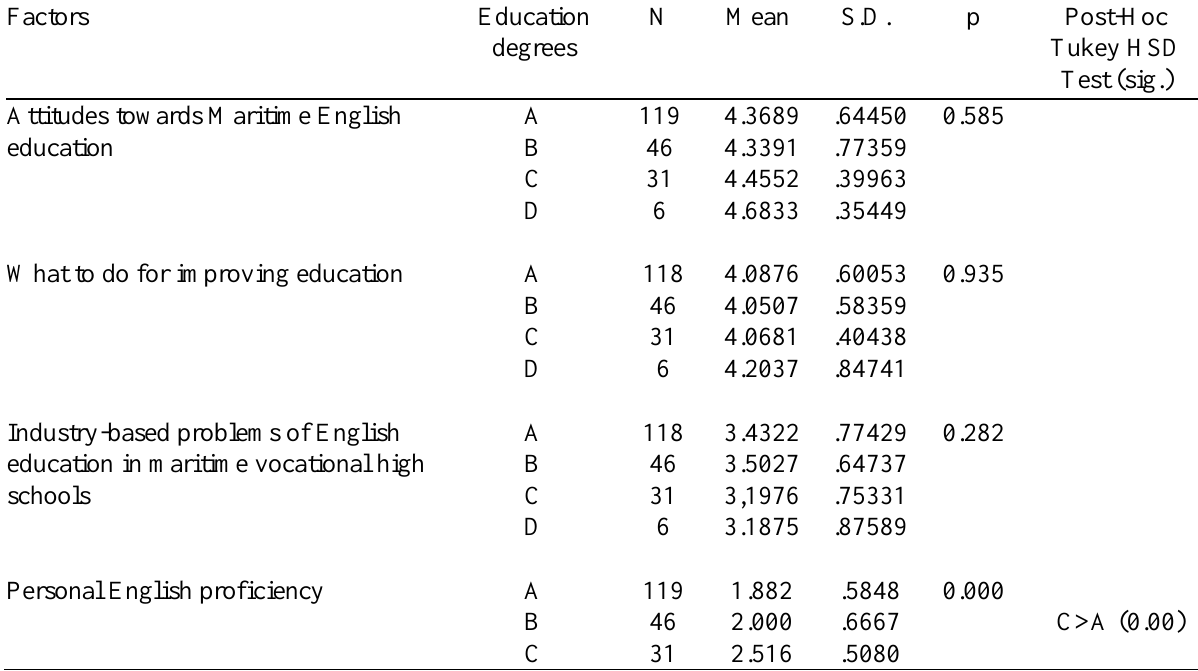
Table 8. The distribution of the average scores of the participants on Maritime English education and